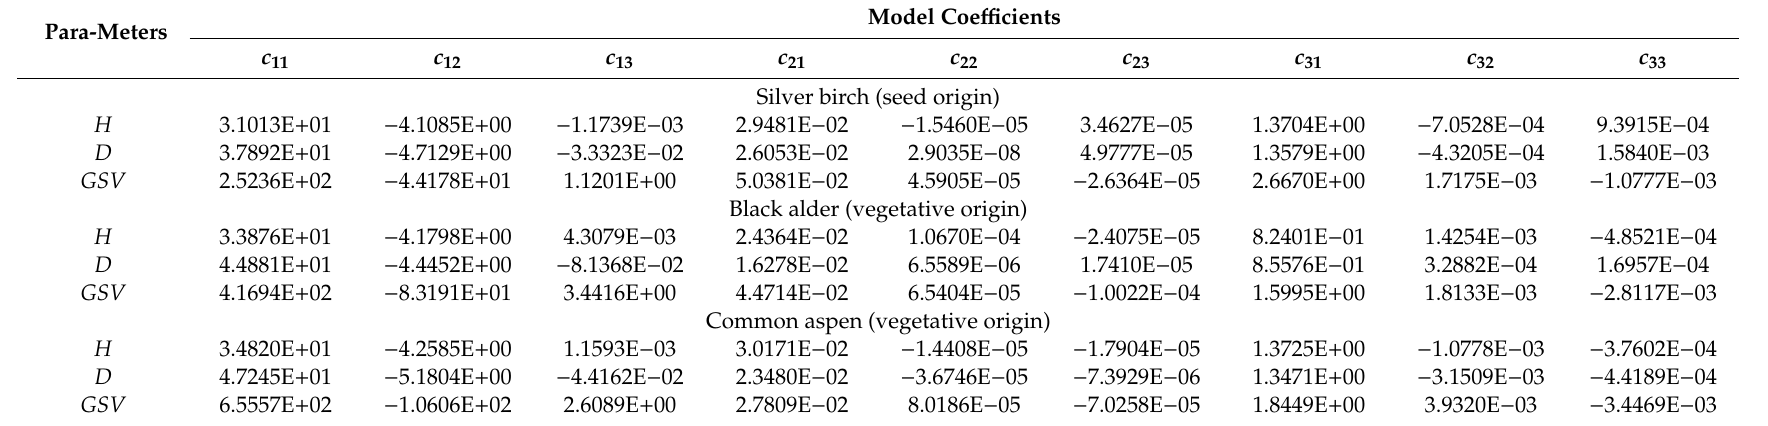
Table A1. Polynomial coe ffi cients (3–5) of developed models of dynamics of major indicators of growth (Equation 2) for studied tree species.